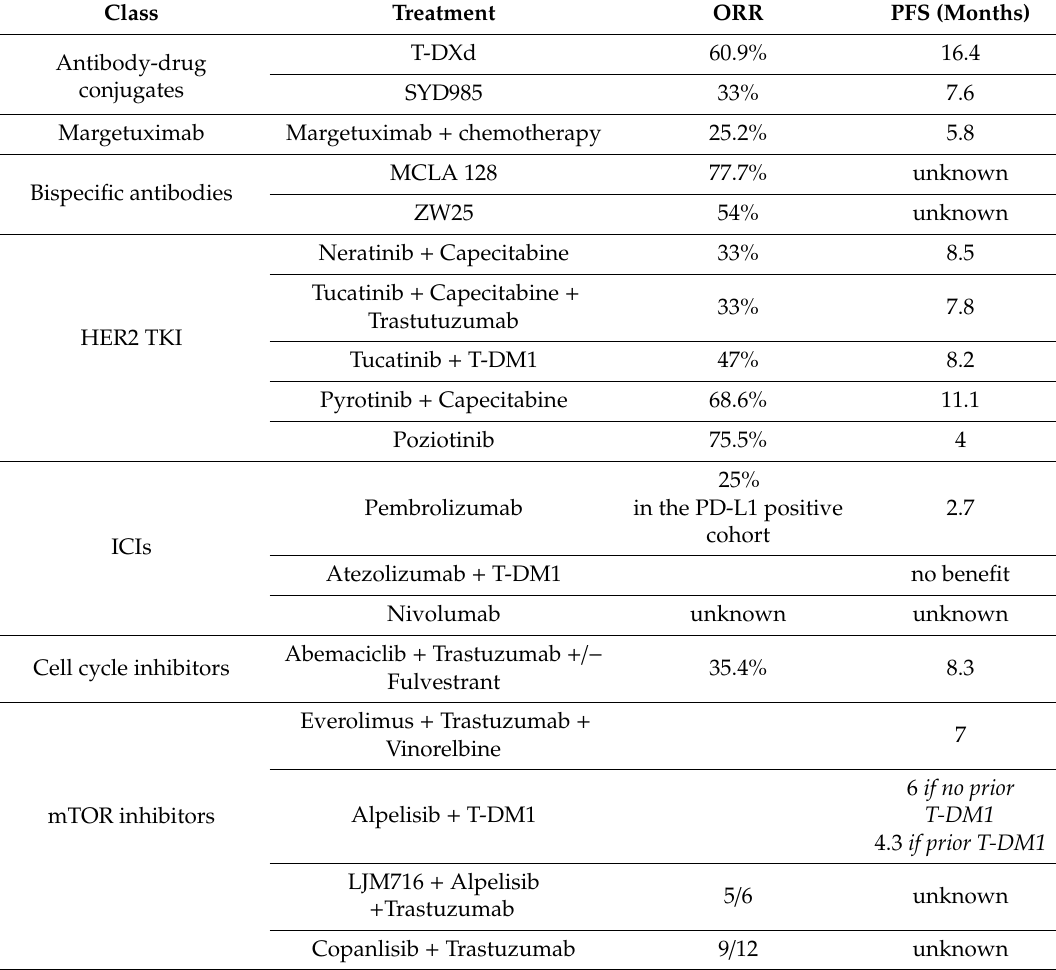
Table 7. Clinical outcomes of novel therapeutics in HER2-positive